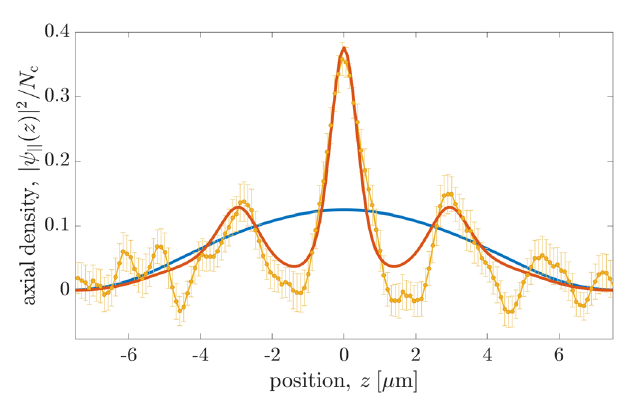
qu (dashed R d x d y ρ ð r Þ (cid:2) H th ð r Þ ,